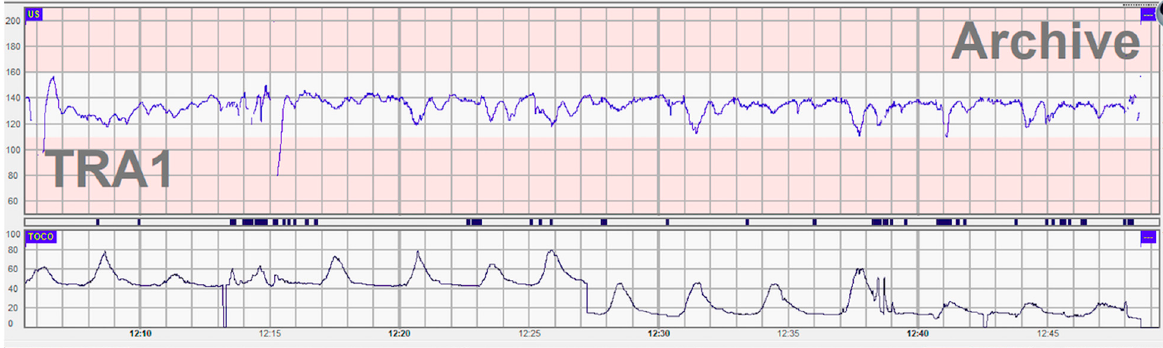
Figure 1. The cardiotocographic aspect during labor.